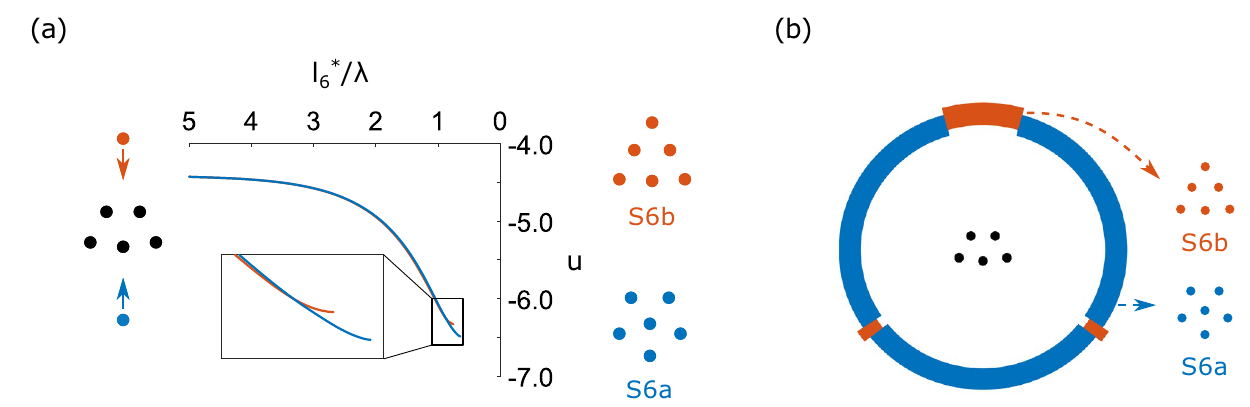
Figure 6. Dynamic simulation results for the transitions from S5 to S6a and S6b for an external magnetic 5 mT . The sixth particle is placed at a distance of 5 (cid:31) from the initial assembly and, depending on the field B z = direction at which the new particle is added, the system will stabilize in one state or the other. ( a ) Dimensionless potential u as a function of the normalized distance of the sixth particle to the center of mass of the five other particles l ∗ 6 / (cid:31) . Two different cases are shown: additional particle up and down, leading to the formation of two different states S6a and S6b. ( b ) Predicted final state as a function of the angle at which the sixth particle is added.